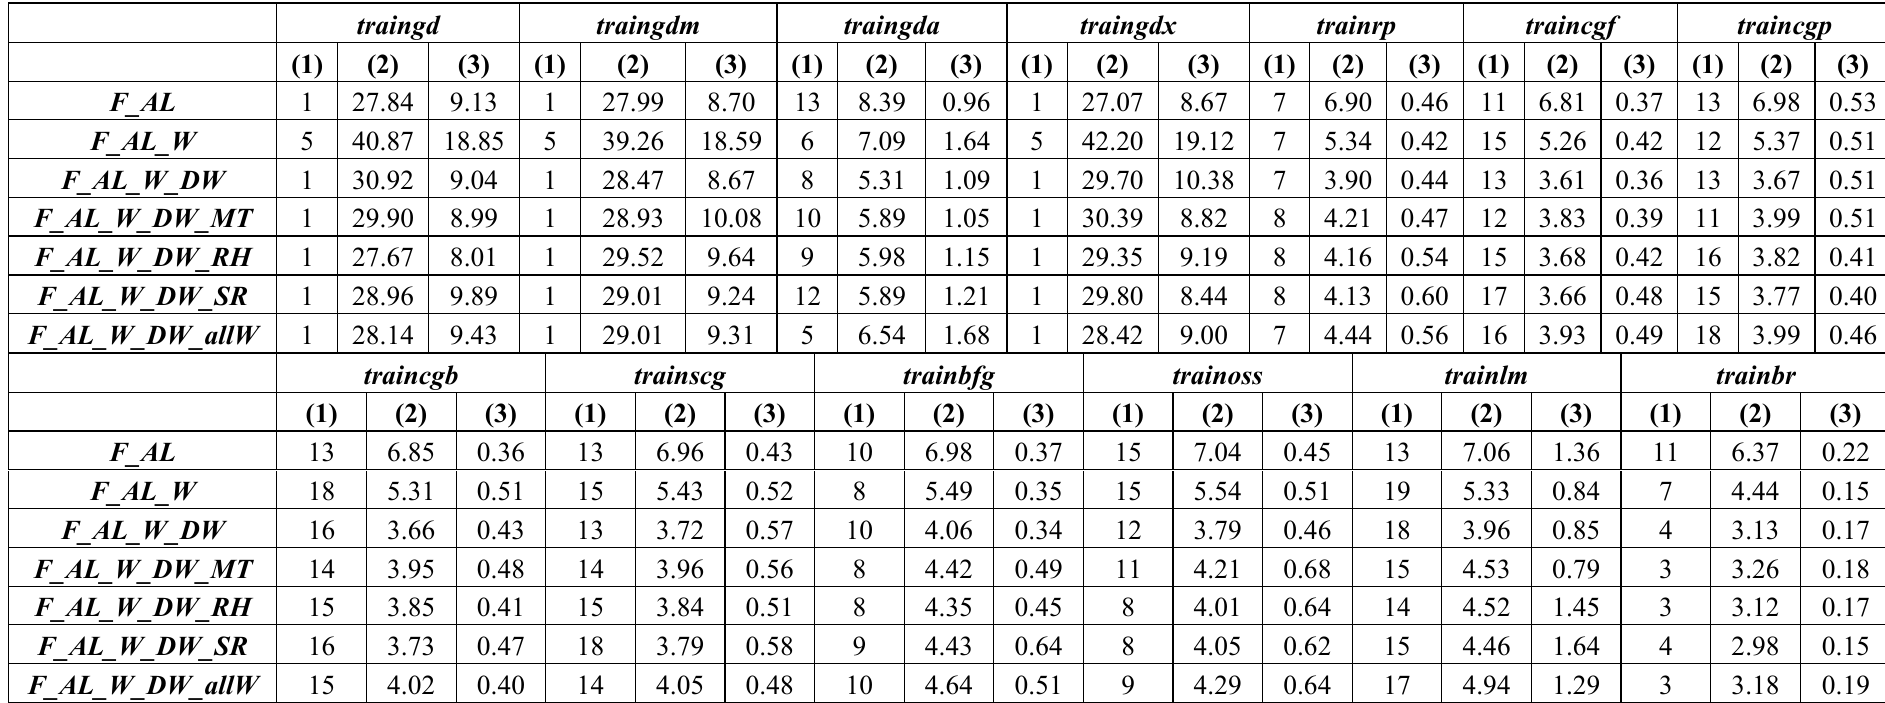
Table 2. Comparison of the minimum MAPE for all the forecast models proposed, after 100 iterations, and for all training functions. Where: (1) optimal number of neurons for the specific model and training functions; (2) MAPE (%) for the optimal number of neurons; and (3) standard deviation (%) for the optimal number of